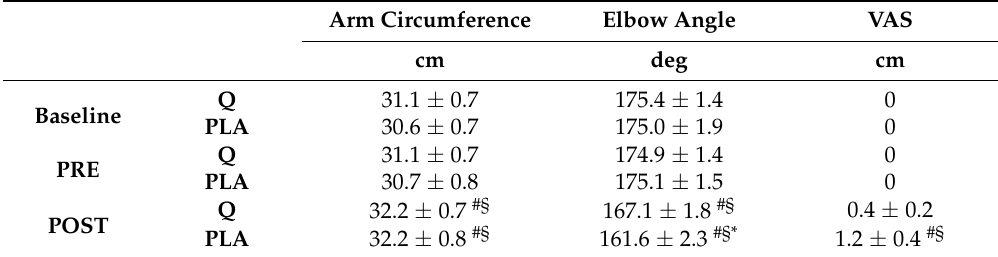
Table 2. Mean absolute values of arm circumference, relaxed elbow angle and visual analogue scale (VAS) recorded at baseline (BASE), before (PRE) and after (POST) the eccentric exercise in Q and PLA conditions.